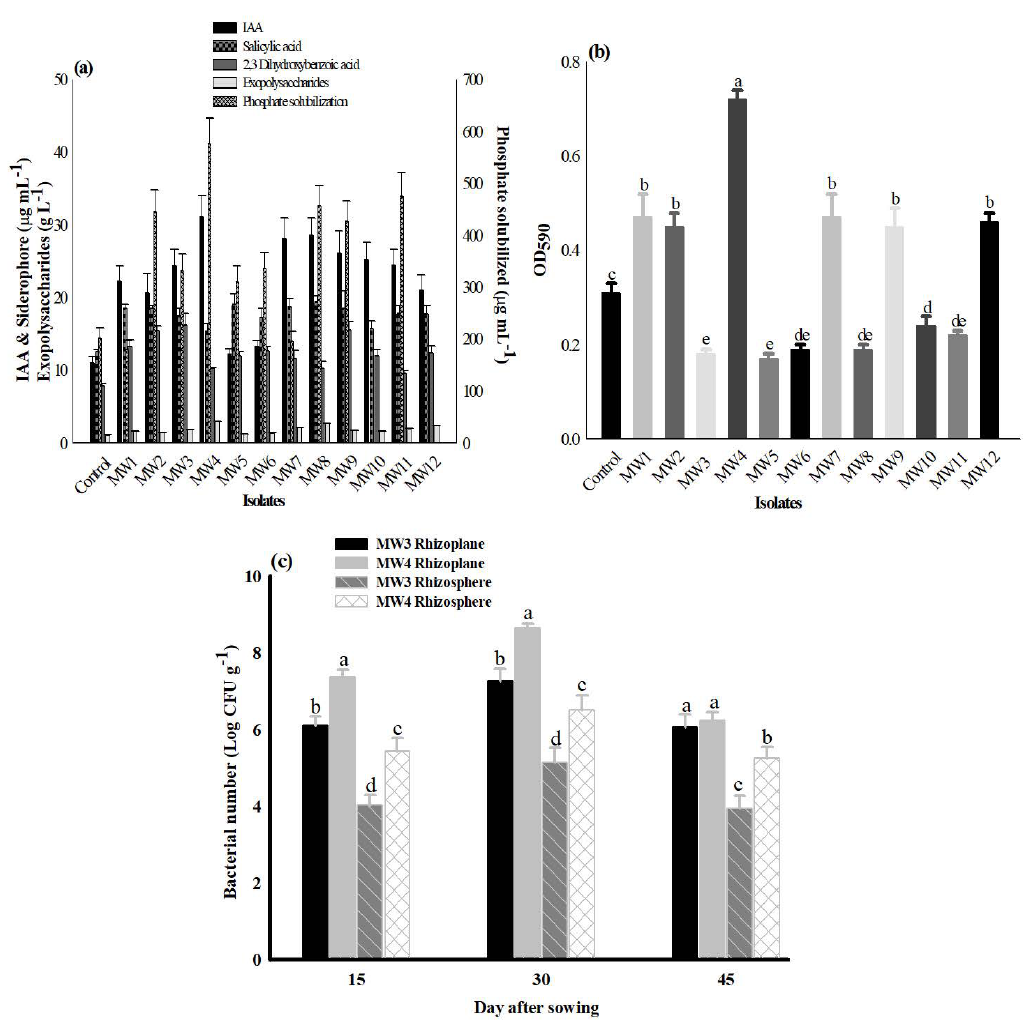
Fig. 1. Plant growth promoting activities and biofilm formation by fluorescent Pseudomonas strains. (a) Plant growth promoting traits of test strains. (b) Biofilm formation on 96 well microtiter plates under stationary conditions. Bar values followed by a different letters are significantly different ( a = 0.05) in Duncan’s multiple range test. MTCC-1749 was used as positive control. (c) Survival and colonization of MW3, MW4 (rifampicin resistant mutant) with wheat rhizoplane and rhizosphere in natural soil conditions. Bar values followed by a different letters are significantly different ( a = 0.05) in Duncan’s multiple range